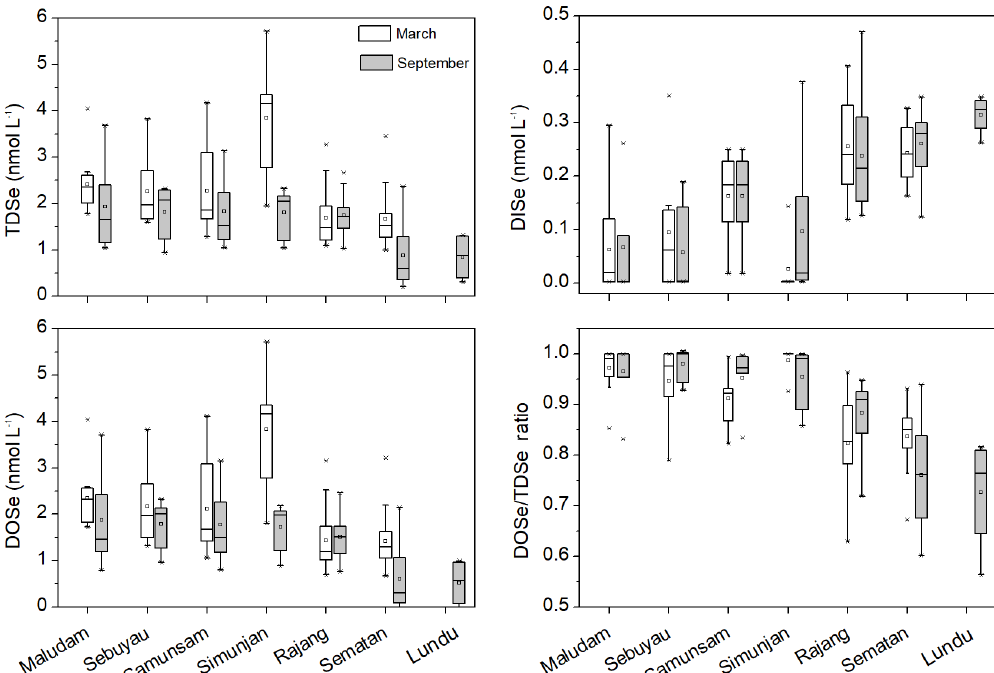
Figure 2. The box plot of TDSe, DISe and DOSe concentration and DOSe / TDSe ratio in the sampled rivers and estuaries in Malaysia in March and September 2017, respectively. The ends of the boxes, the ends of the whiskers, and the line across each box represent the 25th and 75th percentiles, the fifth and 99th percentiles, and the median, respectively; the open square indicates the mean